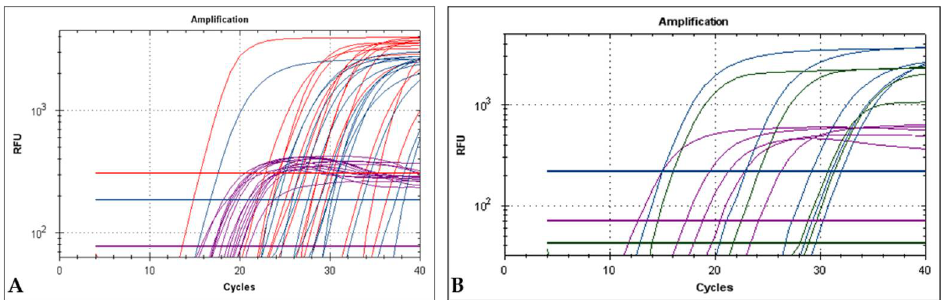
Figure 5. ( A ) Results in field samples positive to ha-MYXV (red sigmoid curves: m060L , Texas Red channel; blue sigmoid curves: m000.5L/R , FAM channel; green flat lines: m009L, HEX channel, not visible due to scale). ( B ) Results with field samples positive for classic MYXV (blue curves: m000.5L/R , FAM channel; green curves: m009L , HEX channel, red flat lines: m060L , Texas Red channel, not visible due to scale). All samples were positive for 18S rDNA amplification (CY5, purple curves). Table 7. Comparison of the qualitative results obtained with the m000.5L/R singleplex and quadru- plex.